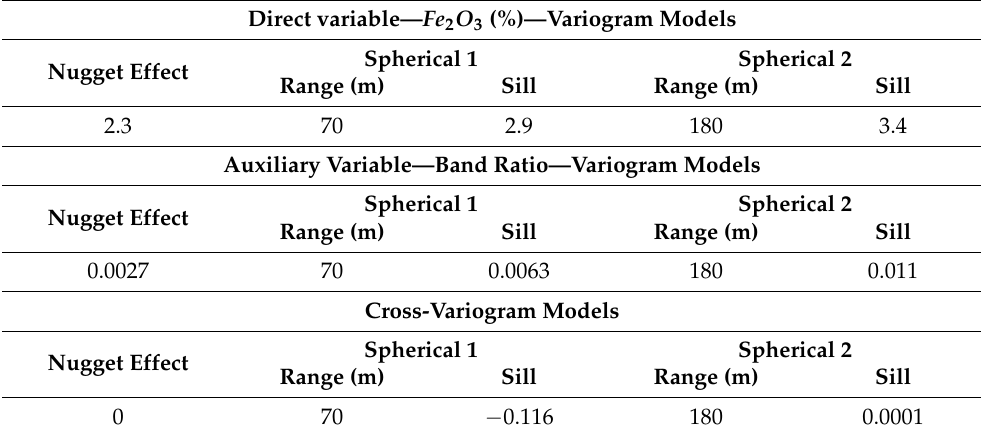
Table 3. Structures and parameters of variogram models fitted on Fe 2 O 3 (%) samples, ferrous iron oxides band ratio, and cross-variogram.